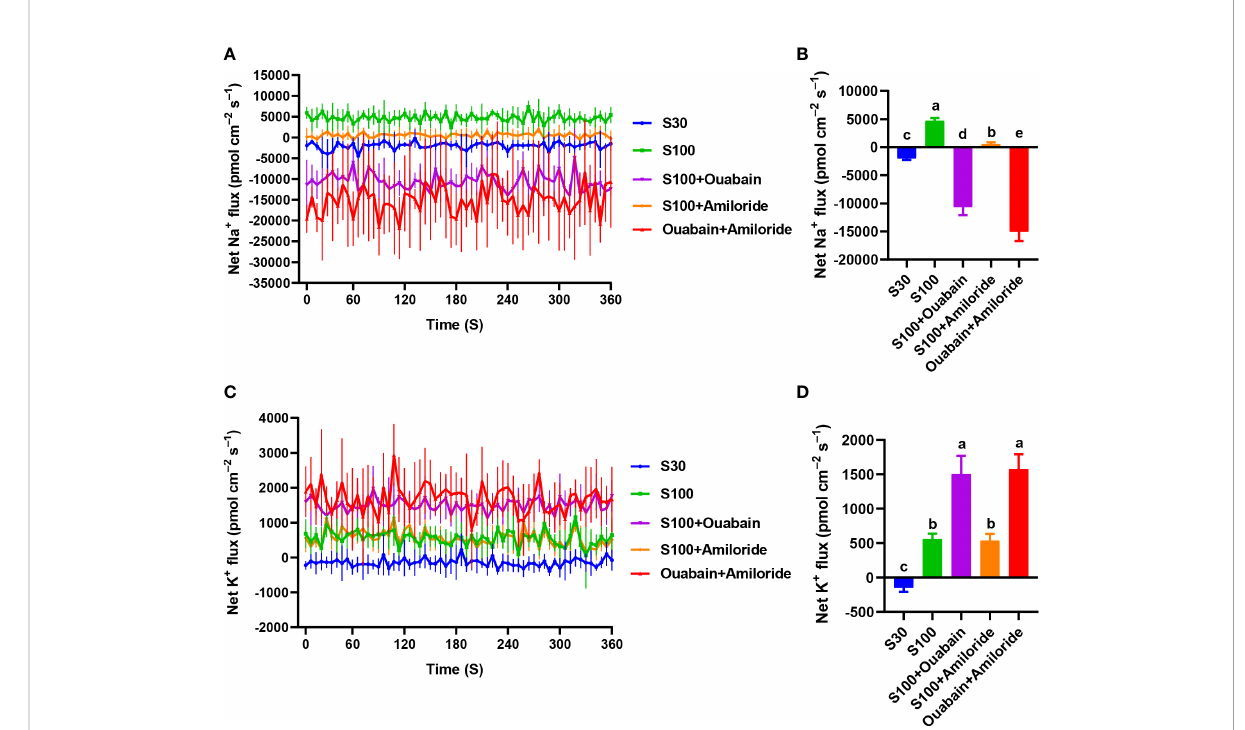
FIGURE 3 Effects of hypersaline (100 ‰ , 15 min) and inhibitor treatments on net Na + and K + fl uxes. (A) Na + fl uxes in the presence of ouabain and amiloride under hypersaline stress. (B) Mean rate of Na + fl ux in thalli. (C) K + fl uxes in the presence of ouabain and amiloride under hypersaline stress. (D) Mean rate of K + fl ux in thalli. S30: control salinity (30 ‰ ). S100: hypersaline stress (100 ‰ ). Each value is the mean of six individual thalli during 6 min measurements. Bars represent standard error of the mean ( n = 6). Different letters indicate signi fi cant differences ( P< 0.05) among